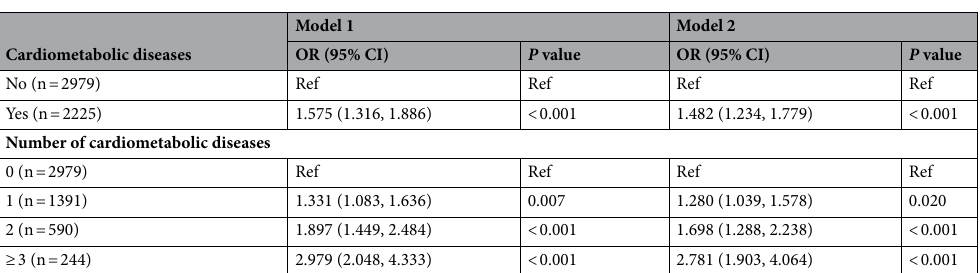
Table 3. Association of cardiometabolic diseases with frailty. Model 1 was adjusted for age, sex, residence, education level, marital status, smoking status, socioeconomic status and body mass index. Model 2 was adjusted as model 1 with further adjustment for lung disease, liver disease, kidney disease, stomach disease, arthritis or rheumatism, and